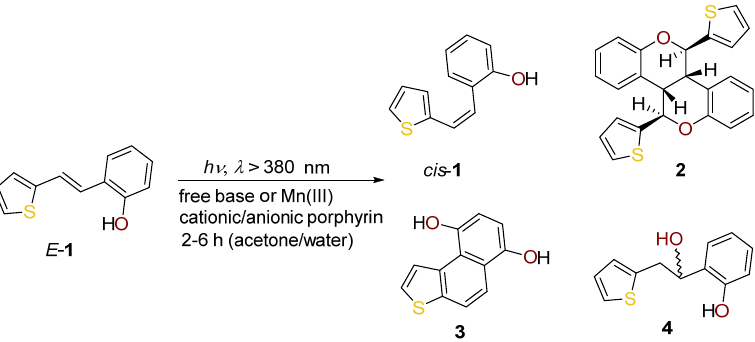
Scheme 1. Reaction pathway for the photocatalytic reactions of E - 1 into photoproducts Z - 1 and 2- 4 .